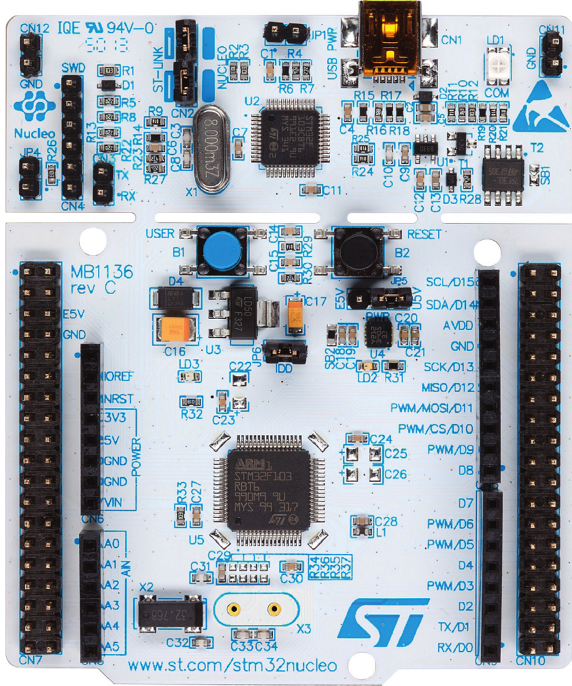
Figure 14: STM32F103 nucleo board with a 32bit RISC processor.